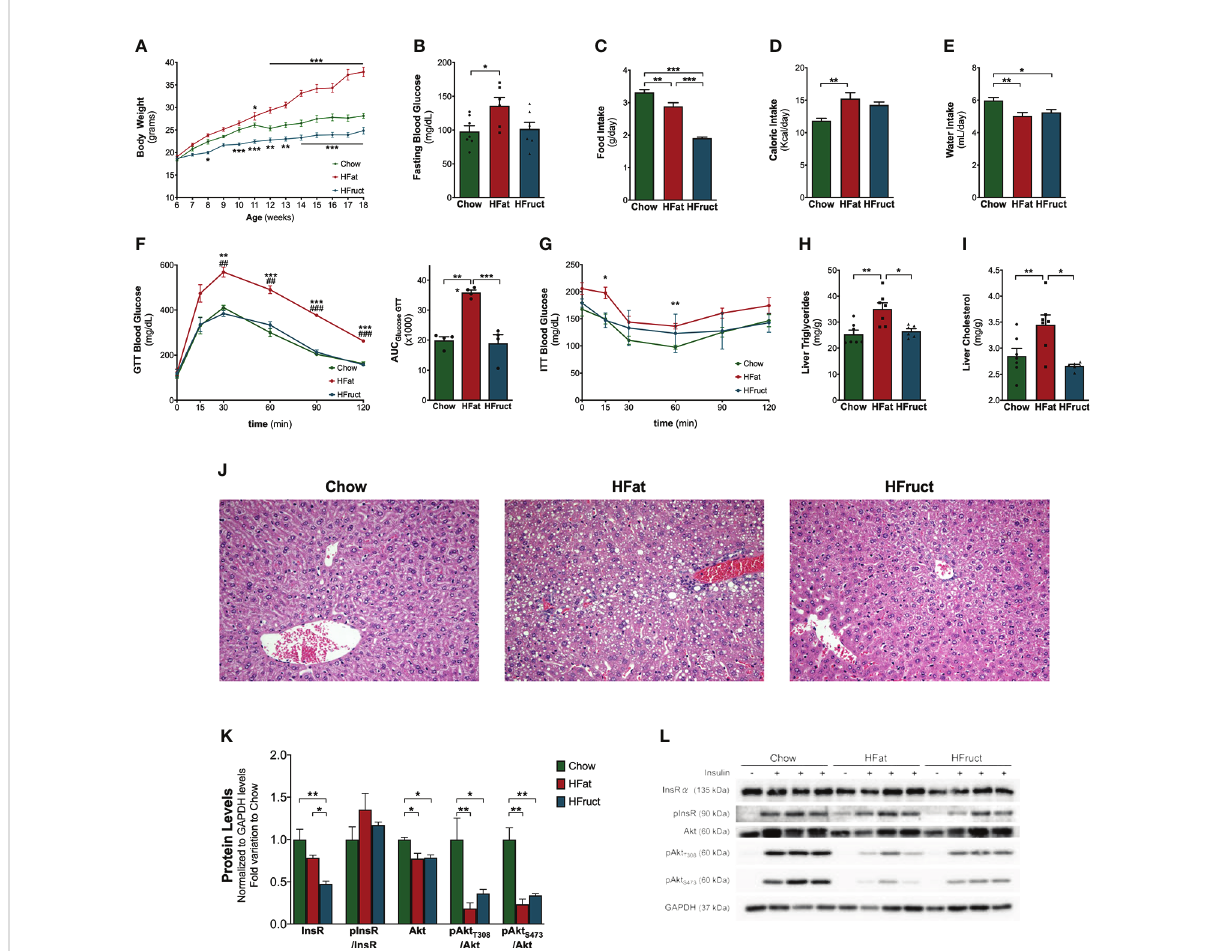
FIGURE 1 Effects of HFat and HFruct diets on metabolic parameters, glucose homeostasis, hepatic lipid deposition, and insulin signaling pathway in C57Bl/ 6J male mice. (A) Body weight, (B) intraperitoneal glucose tolerance test (ipGTT) and the respective area under the curve (AUC), (C) insulin tolerance test (ITT); (D) fasting blood glucose; (E) food intake; (F) water intake; (G) caloric intake; (H) hepatic triglycerides; (I) hepatic cholesterol levels; (J) representative images of hematoxylin and eosin-stained liver sections; (K) Chow, high-fat (HFat) and high-fructose (HFruct) hepatic protein levels of insulin receptor a (InsR), phosphorylated-insulin receptor (pInsR; normalized to InsR levels); protein kinase B (PKB/Akt) and its phosphorylation sites (pAkt T308 and pAkt S473 ; normalized to Akt levels) normalized to GAPDH levels and represented as fold variation to Chow group; (L) representative images of Western blot for the described antibodies. Data are presented as mean ± SEM for three to seven mice. *p<0.05, **p<0.01, ***p<0.001; (F) ## p<0.01 vs. HFruct, ### p<0.001 vs.